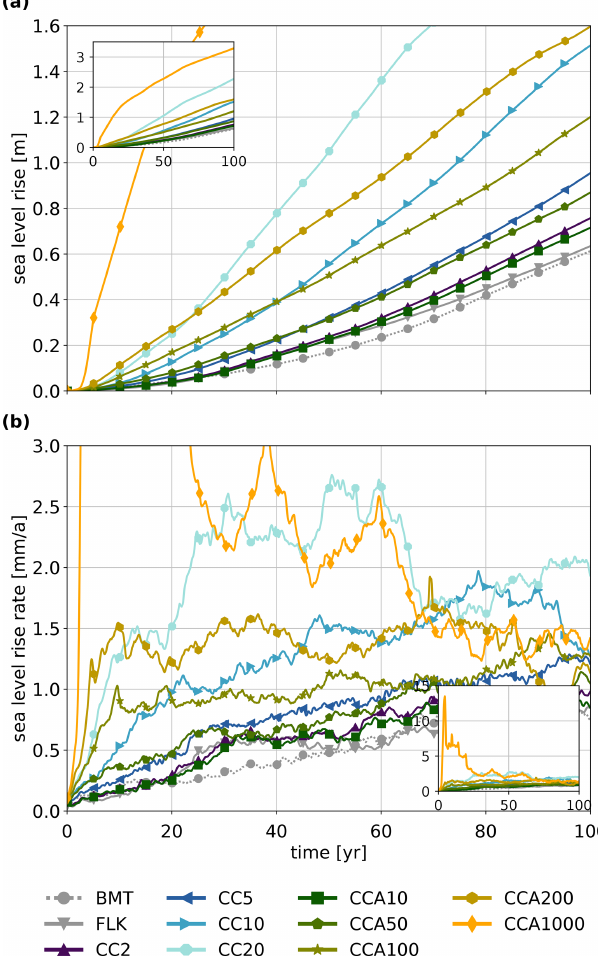
Figure 3. Cumulative sea-level contribution (a) and rate of sea- level rise (b) relative to the reference run for all experiments car- ried out. The insets shows the same plot but with a larger range so that the curve of the CCA1000 experiment is shown